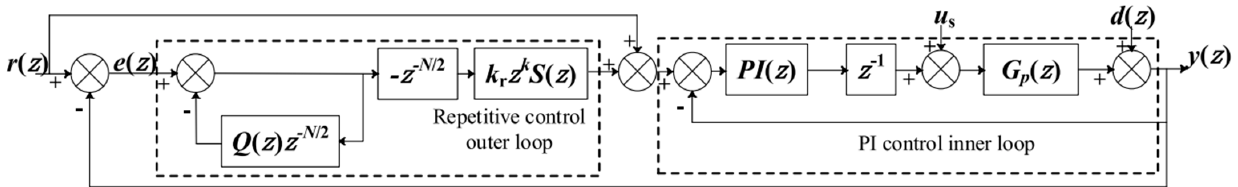
Figure 15. Structure of PI + repetitive controller.